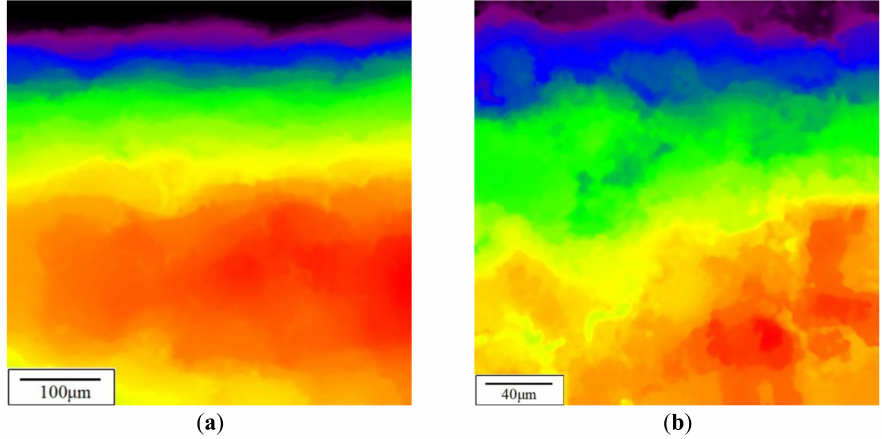
Figure 10. Infrared signal images after random vibration test. ( a )100 × ; ( b ) 250 ×